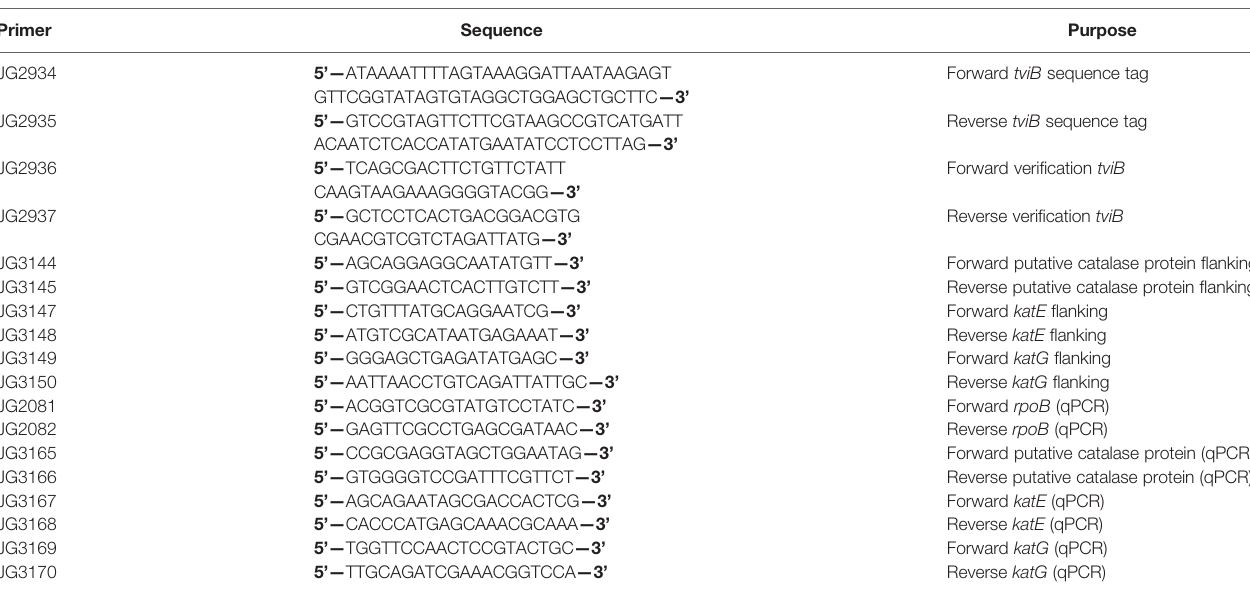
TABLE 3 | Oligonucleotide primers used in this study.